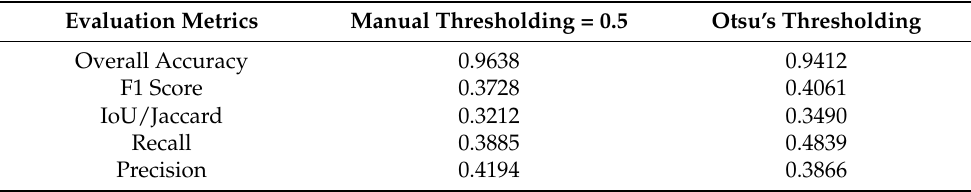
Table 6. Results of manual thresholding and Otsu’s thresholding.